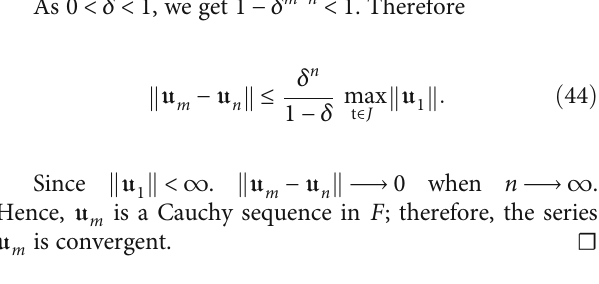
for μ = 0 : 75 . (c) NTDM CF